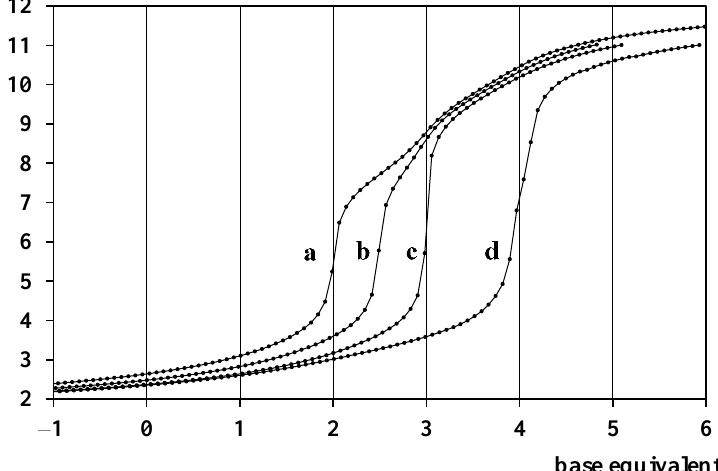
Figure 5. Representative titration curves of the H + –L5 ( a ) system and the [( η 5 -Cp*)Rh] 2+ –L5 system at 1:2 ( b ), 1:1 ( c ) and 2:1 ( d ) metal-ion-to-ligand-ratio s (c L5 = 2.49 mM). Negative base equivalent refers to an excess of acid in the